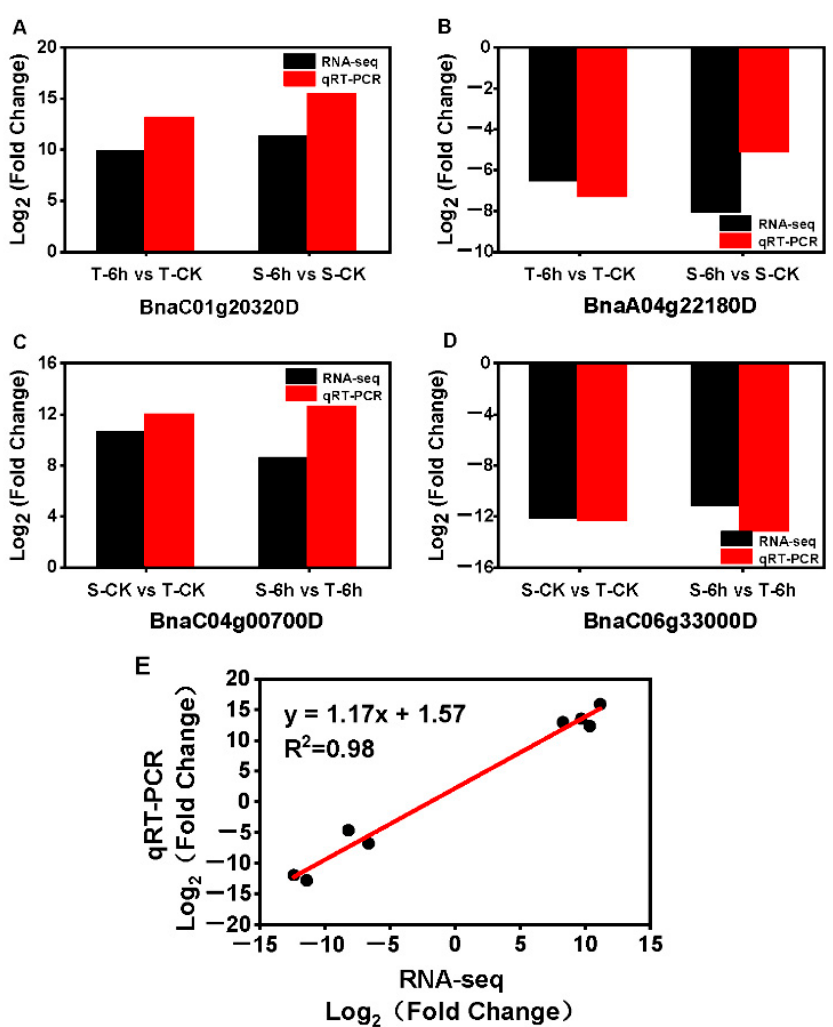
Figure 4. Validation of RNA-seq data by qRT-PCR. ( A – D ) The change of expression of 4 representative DEGs between control and flooding were compared based on RNA-seq and qRT-PCR data. Three biological replicates were used for the comparison. ( E ) The expression correlation between the RNA-seq and qRT-PCR. Actin7 was served as internal reference gene.